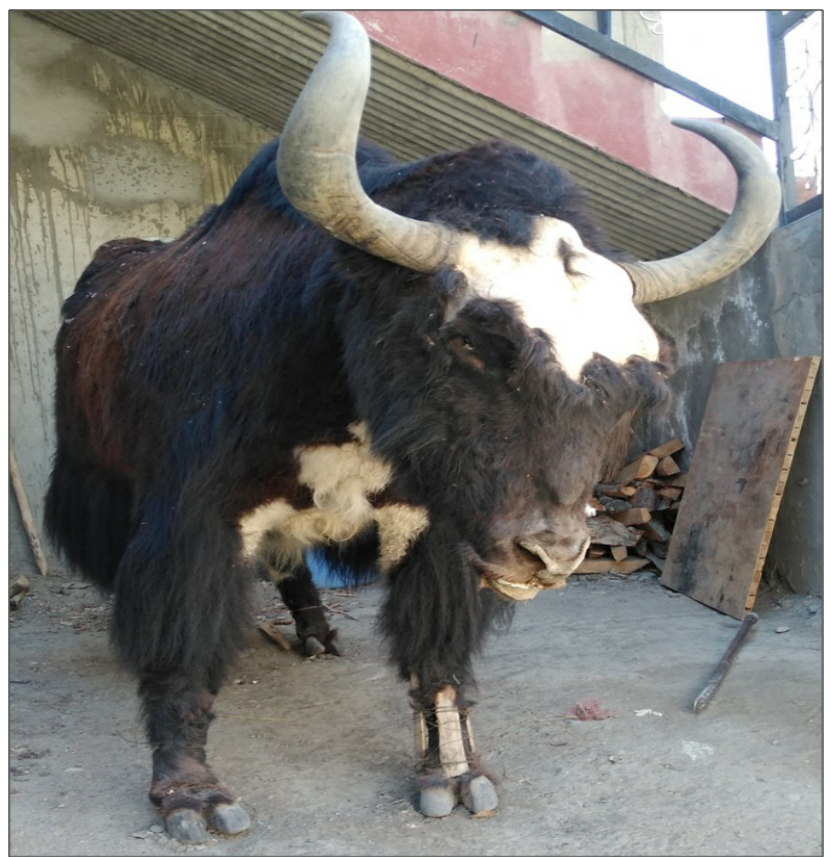
Figure 5. Taxidermied yak in